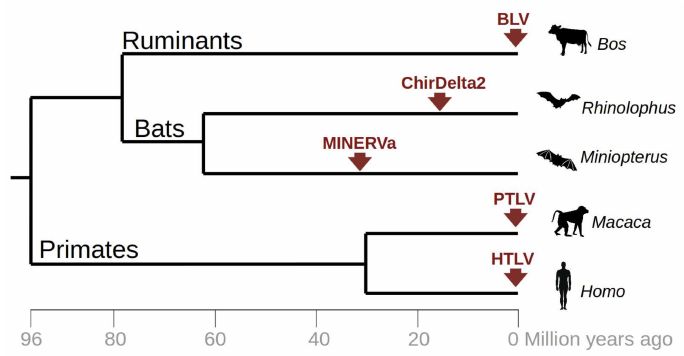
Figure 4. Occurrence of currently known retroviral infections related to Deltaretrovirus genus. The tree represents a chronogram of vertebrate species in which an evidence of deltaretrovirus infection has been documented. Red arrows indicate time of infection for particular viral lineages including both exogenous deltaretroviruses (BLV, HTLV, PTLV) and endogenous viral fragments putatively related to deltaretroviruses (MINERVa, ChirDelta2). The chronogram was reconstructed based on the time estimates from timetree.org.